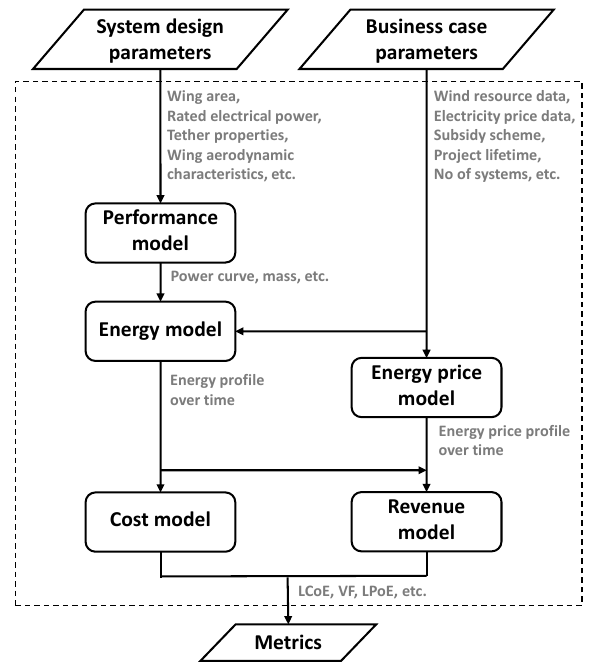
Figure 2. Flowchart of the system design